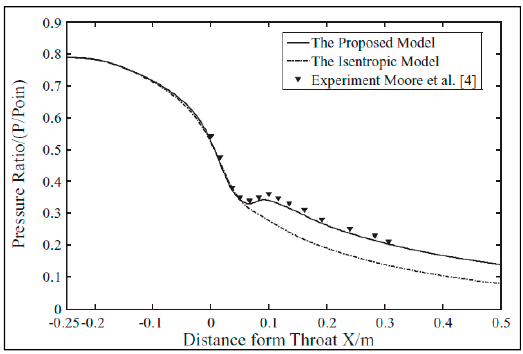
Figure 10. Pressure distribution along the nozzle centerline with condensation shock [120].